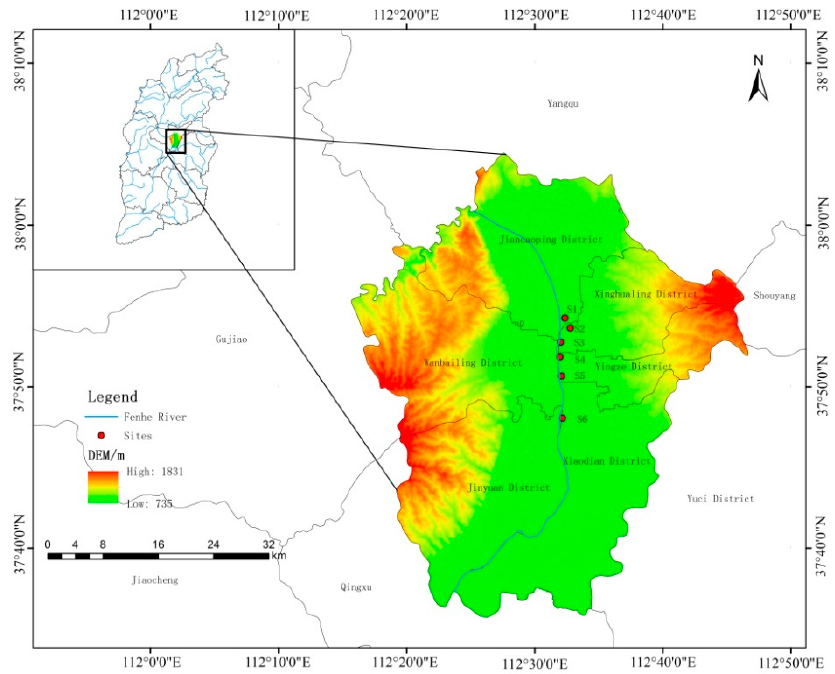
Figure 1. Distribution of sampling points in Taiyuan urban section of Fenhe River.